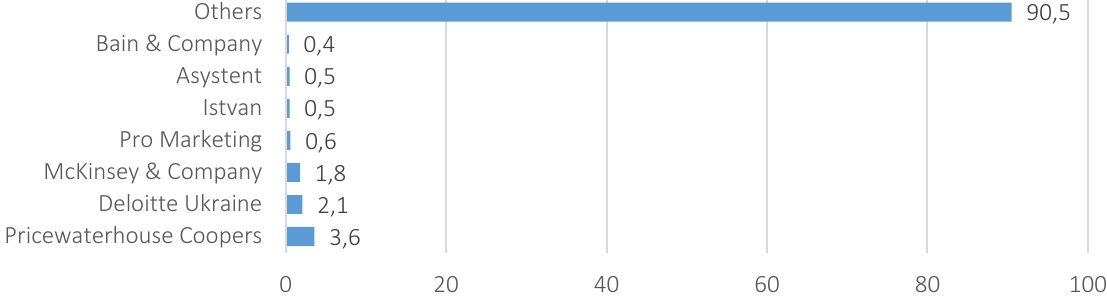
Figure 3. Distribution of market shares (%) on the consulting services market of Ukraine in